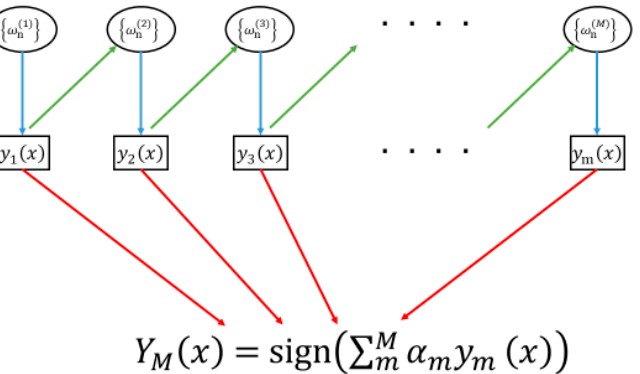
Figure 2. A schematic diagram of the XGBoost algorithm, where { ω n(3)} is the regularization term, ym(x) is the newly generated tree model, YM(x) is the final tree model, and m is the total number of base tree models.